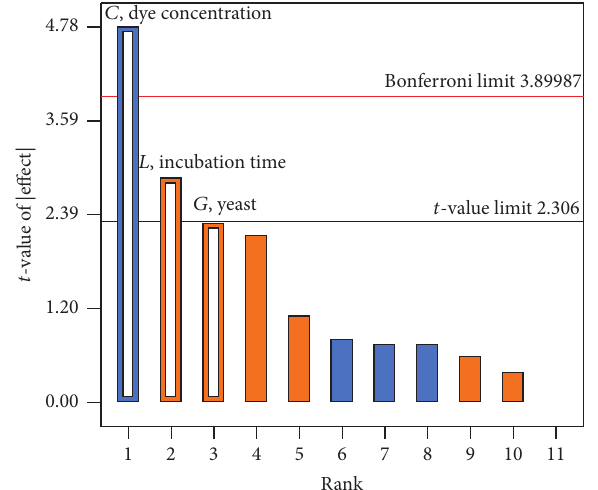
Figure 2: Pareto chart of RBBR dye removal in soil. A – K are the experimental variables as presented in Table